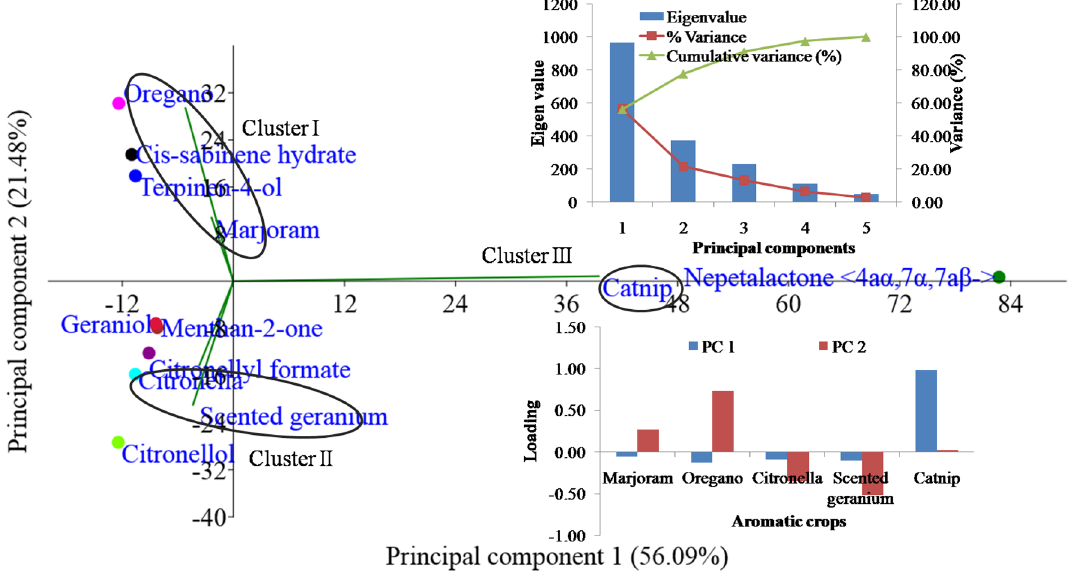
Figure 4. The multivariate analyses of mean value of major compounds of essential oil were conducted through principal component analysis. Principal component 1 and Principal component 2 jointly explained 77.57% of the total variation for aromatic plants grown in the western Himalaya; the eigenvalues and loading scores of the variables with PC1 and PC2 are presented at top right and bottom right corner of the figure, respectively.